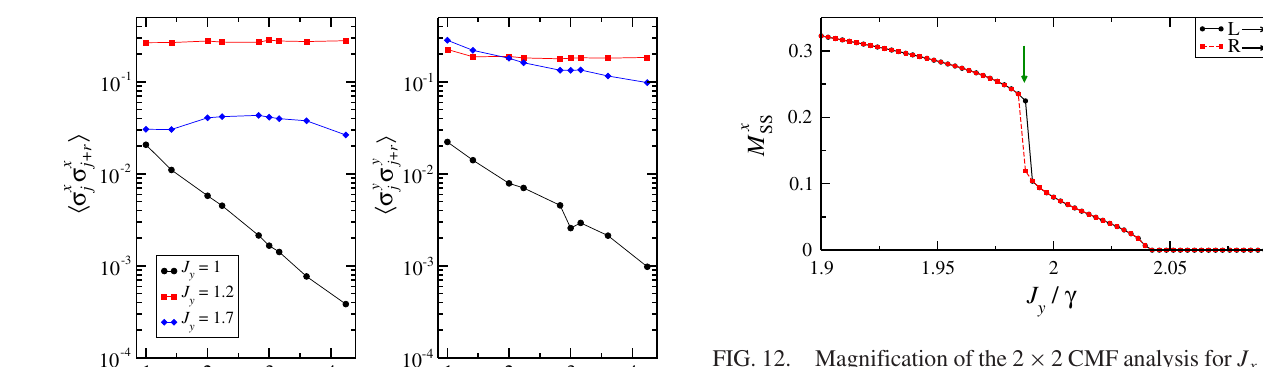
of a FM phase (notice that this point lies well inside the closed region in Fig. 8). The case J y ¼ 1 . 7 (blue data) shows a subtler behavior and corresponds to a point for which the single-site and the 2 × 2 mean-field analysis would predict a symmetry-broken phase, contrary to our l ≥ 3 CMF calculations which display no evidence of this